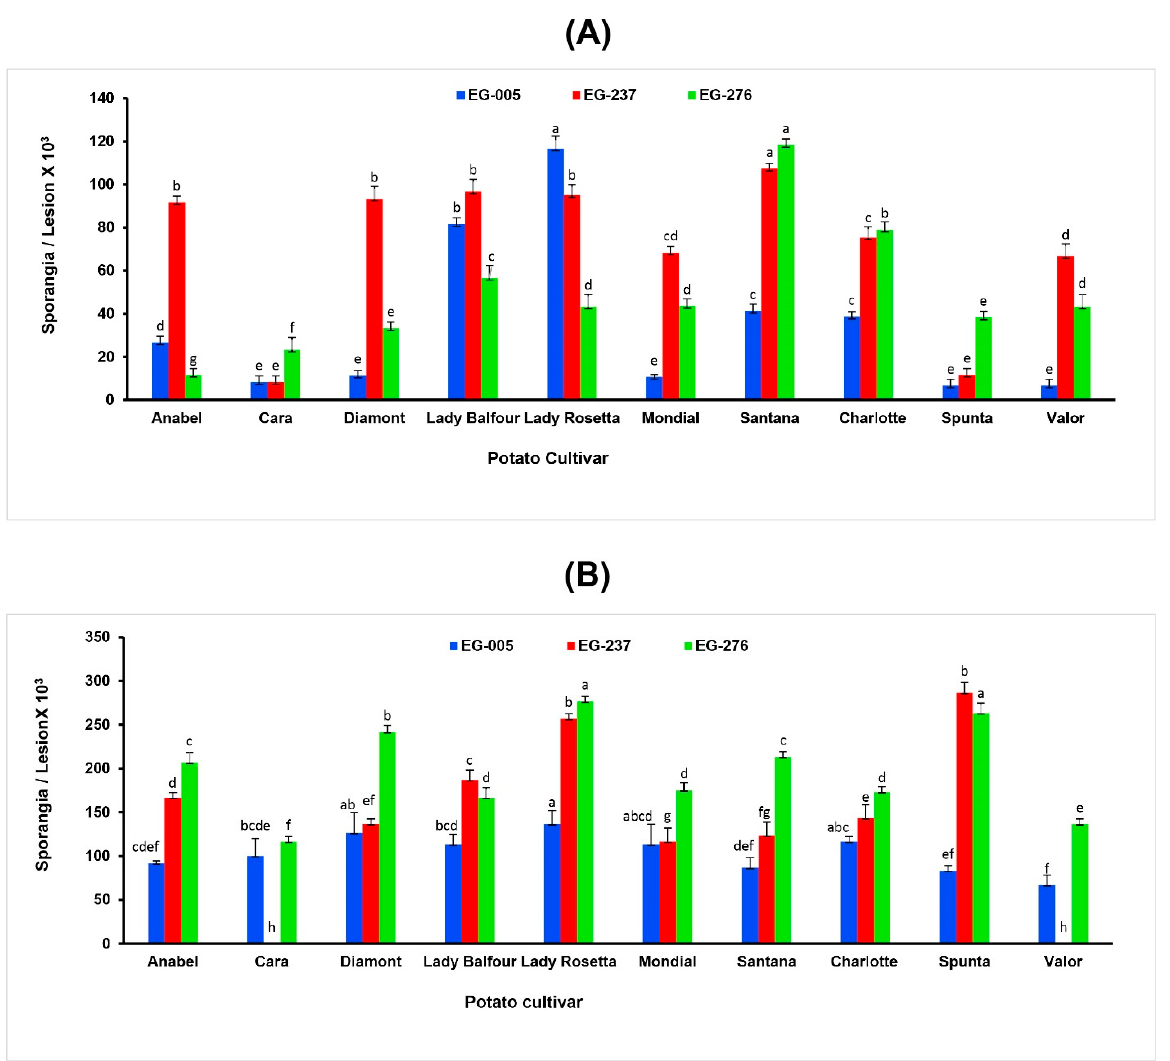
Figure 4. Number of sporangia ( × 10 3 ) of P. infestans per lesion from ( A ) tuber slice and ( B ) detached leaflet infection assays on 10 potato cultivars. Columns bearing the same letters are not significantly different according to the Least Significant Difference (LSD) test ( P < 0.05).